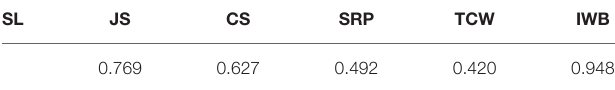
TABLE 5 | Hypotheses